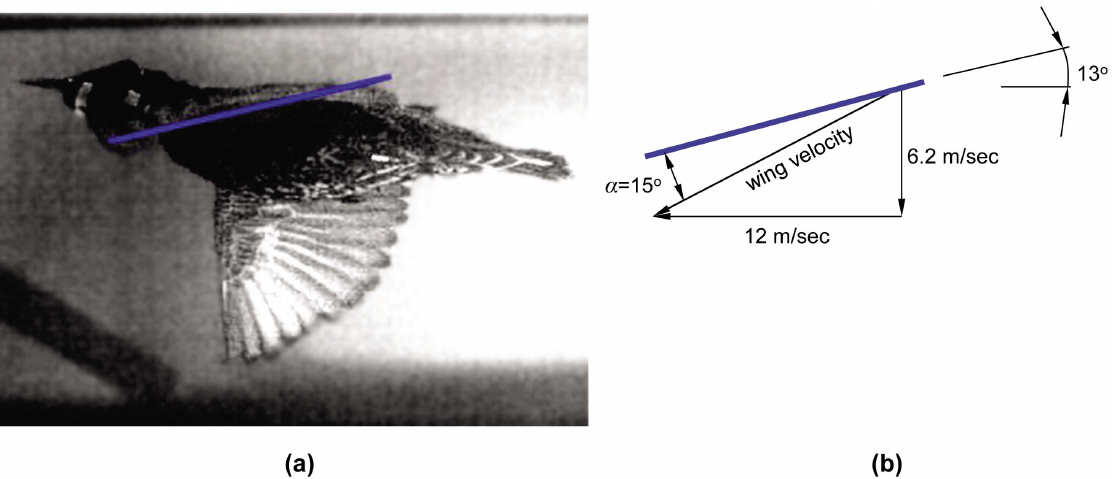
Figure 5. An estimation of the wing’s maximum angle of attack from its instantaneous pitch and velocity relative to the air. In (a), the left wing of the bird points directly at the camera, and the pitch of the chord line at approximately (2/3) b semi is represented by the blue line. In (b), the pitch of the chord line and the velocity of the wing section at (2/3) b semi are used to estimate the angle of attack, a , as approximately 15 u .